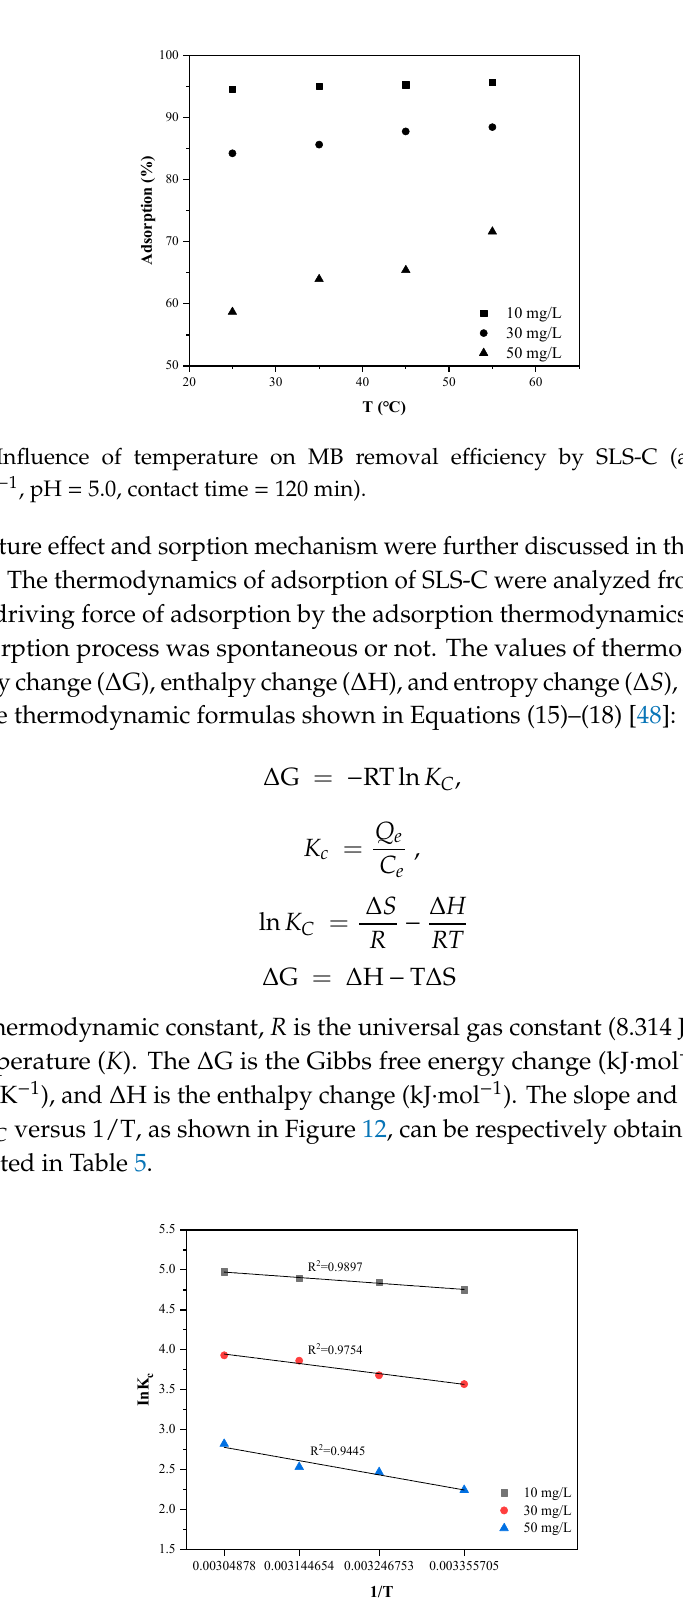
Figure 12. Thermodynamics parameters on the adsorption of MB by SLS-C.